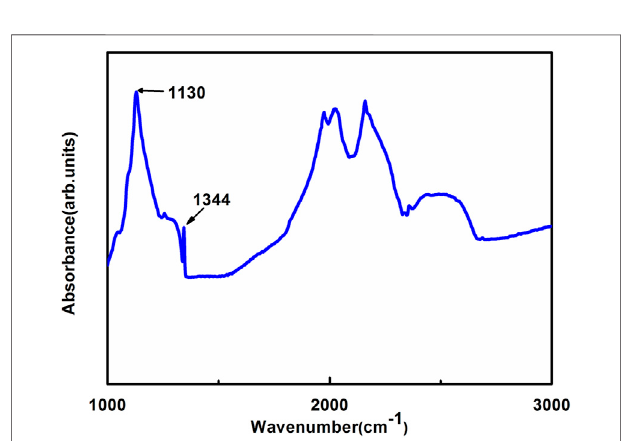
FIGURE4| Open-apertureZ-scancurvesunder532 nmwith200 nJfor the synthetic nitrogen-doped diamond crystal. The circles are the experimental data, and the solid lines are the theoretical fi tting.